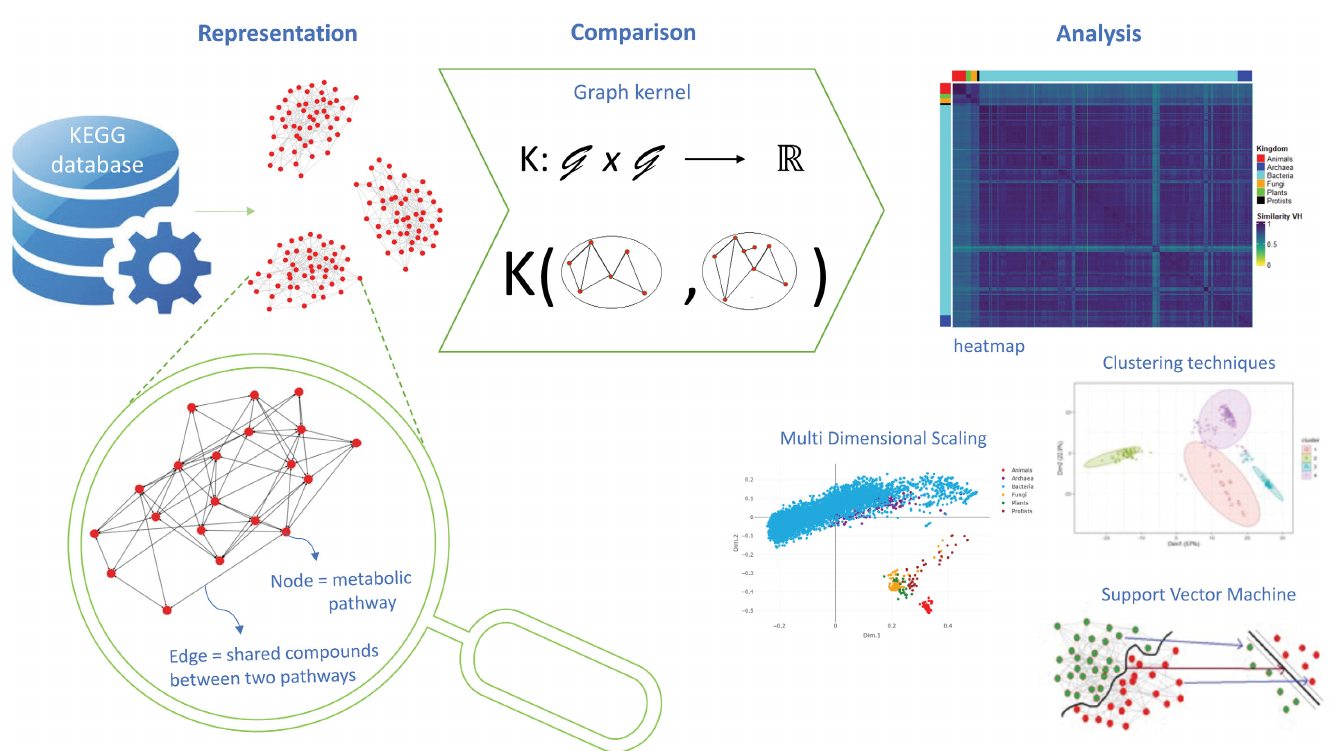
Fig 1. Overall view of the proposed methodology, composed by three steps: Representation, comparison and analysis .